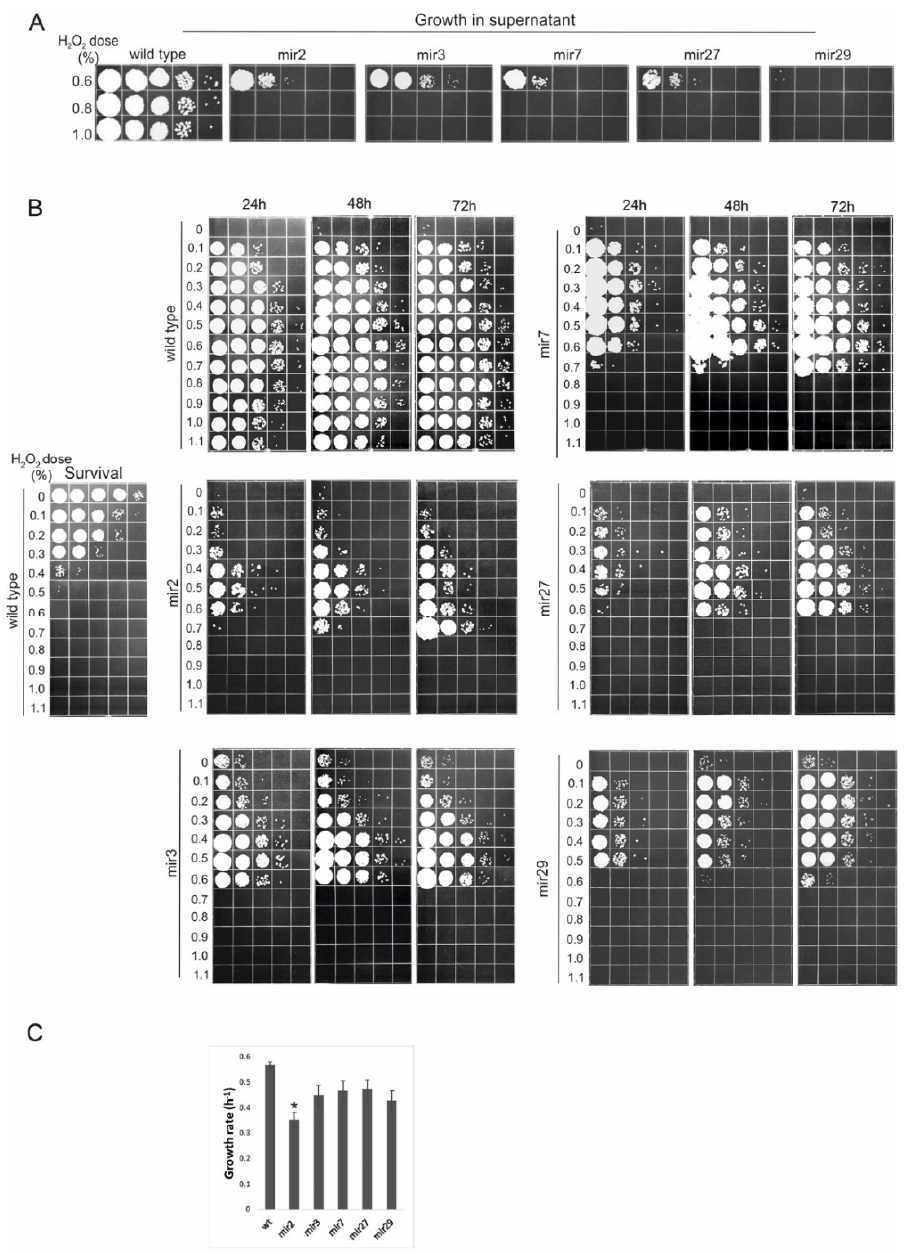
Figure 1. Mutants defective in RUS. ( A ) An amount of 8 × 10 3 wild-type or mutant cells was inoculated in indicated supernatants and growth was examined after 48 h by spotting of ten-fold serial dilutions on a solid growth medium. ( B ) Growth of wild-type and mir mutant cells in cell-free supernatants derived from treatments of wild-type cells (4 × 10 7 ) with increasing peroxide doses (left panel). ( C ) Growth rates of wild-type and mir mutants in complete medium. The error bars indicate standard deviations. Asterisks indicate significant differences ( p < 0.05) between growth rates of each mutant and wild type. All experiments were performed at least three